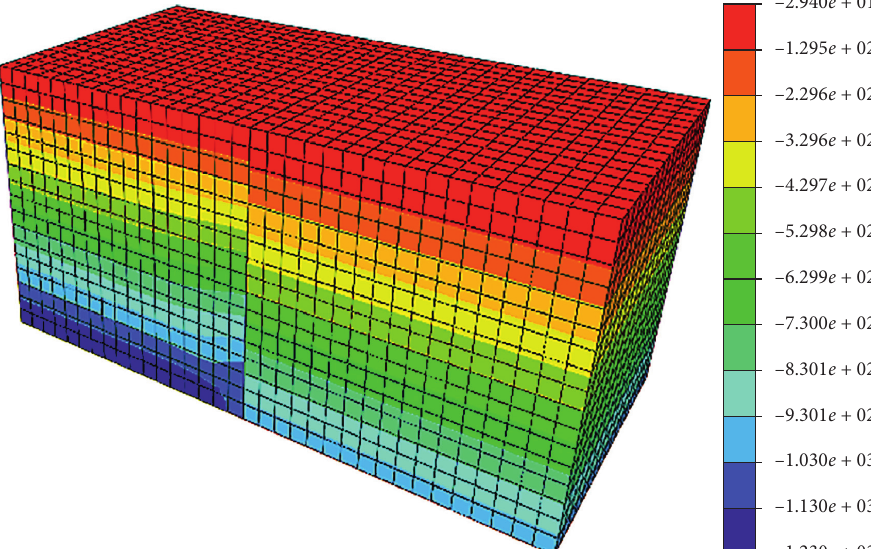
Figure 15: Stress contours of model 2 (unit: